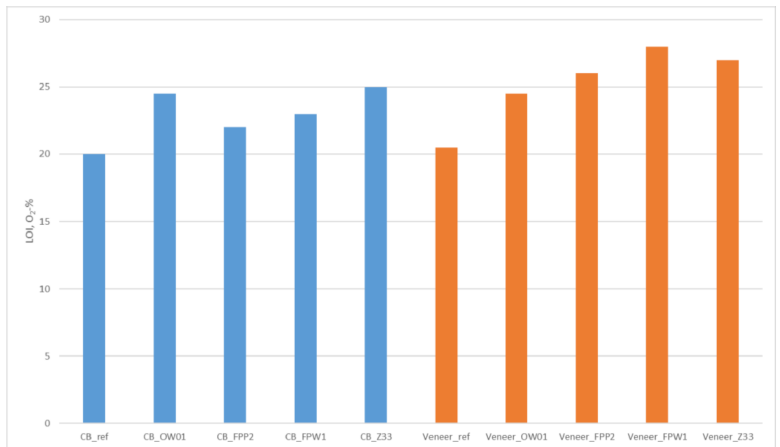
Figure 2. Limiting Oxygen Index (LOI) results for